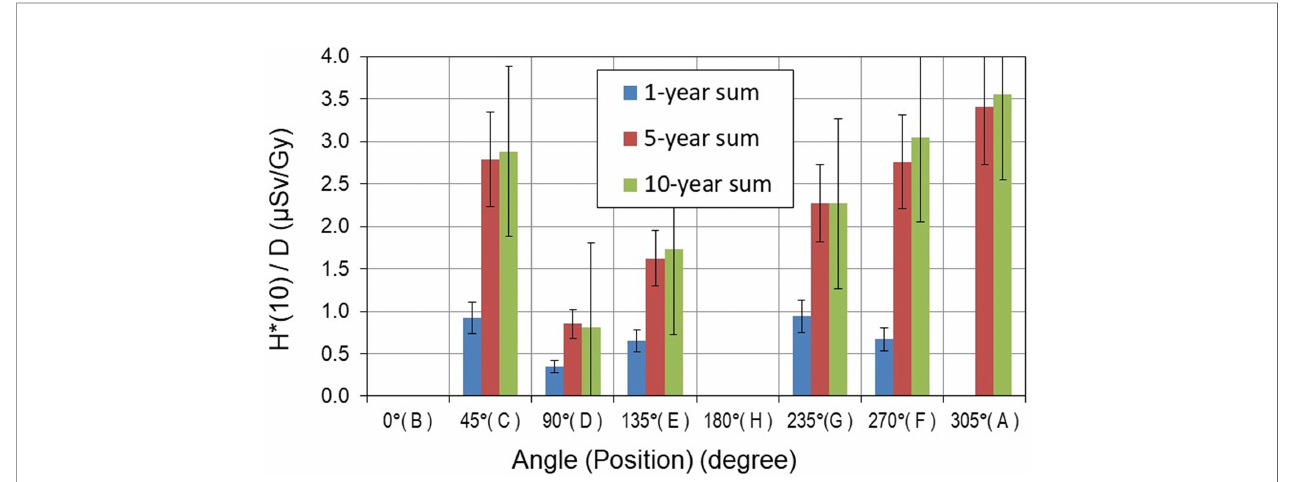
FIGURE 9 | Total neutron ambient dose equivalent H *(10) per treatment Gy [ m Sv/Gy] measured around pediatric phantoms. The error bars represent the standard